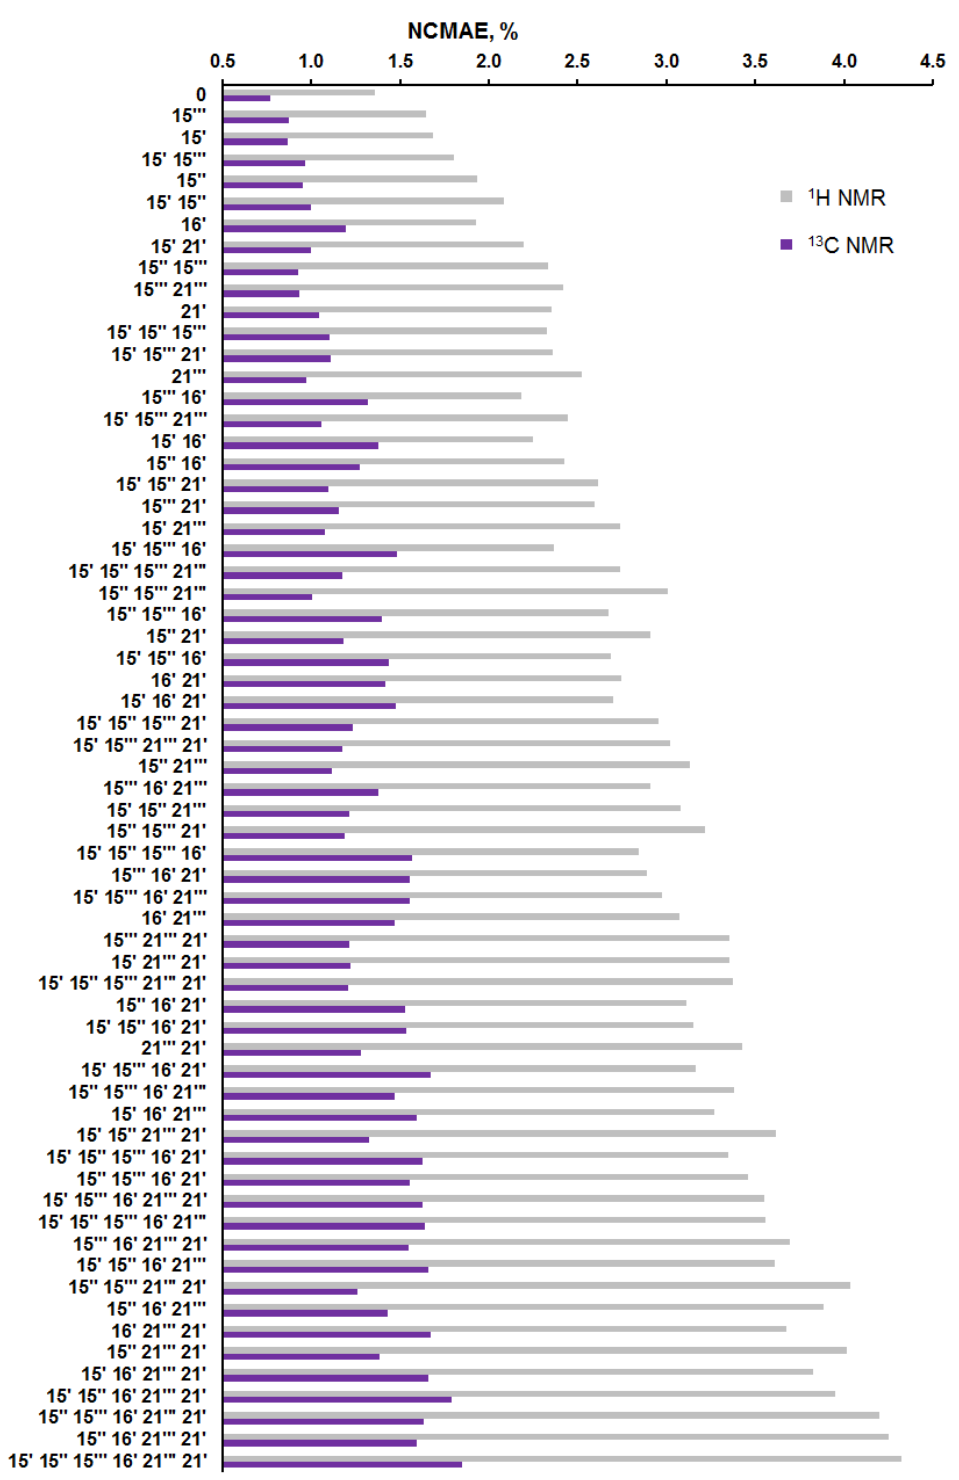
Figure 8. Distribution of the normalized CMAE values (%) of 64 alternate diastereomers of alasmontamine A.